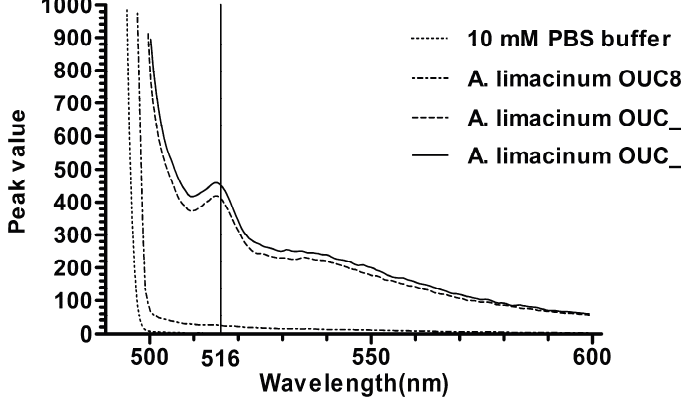
Figure 5. Fluorescence measurements for the recombinants.